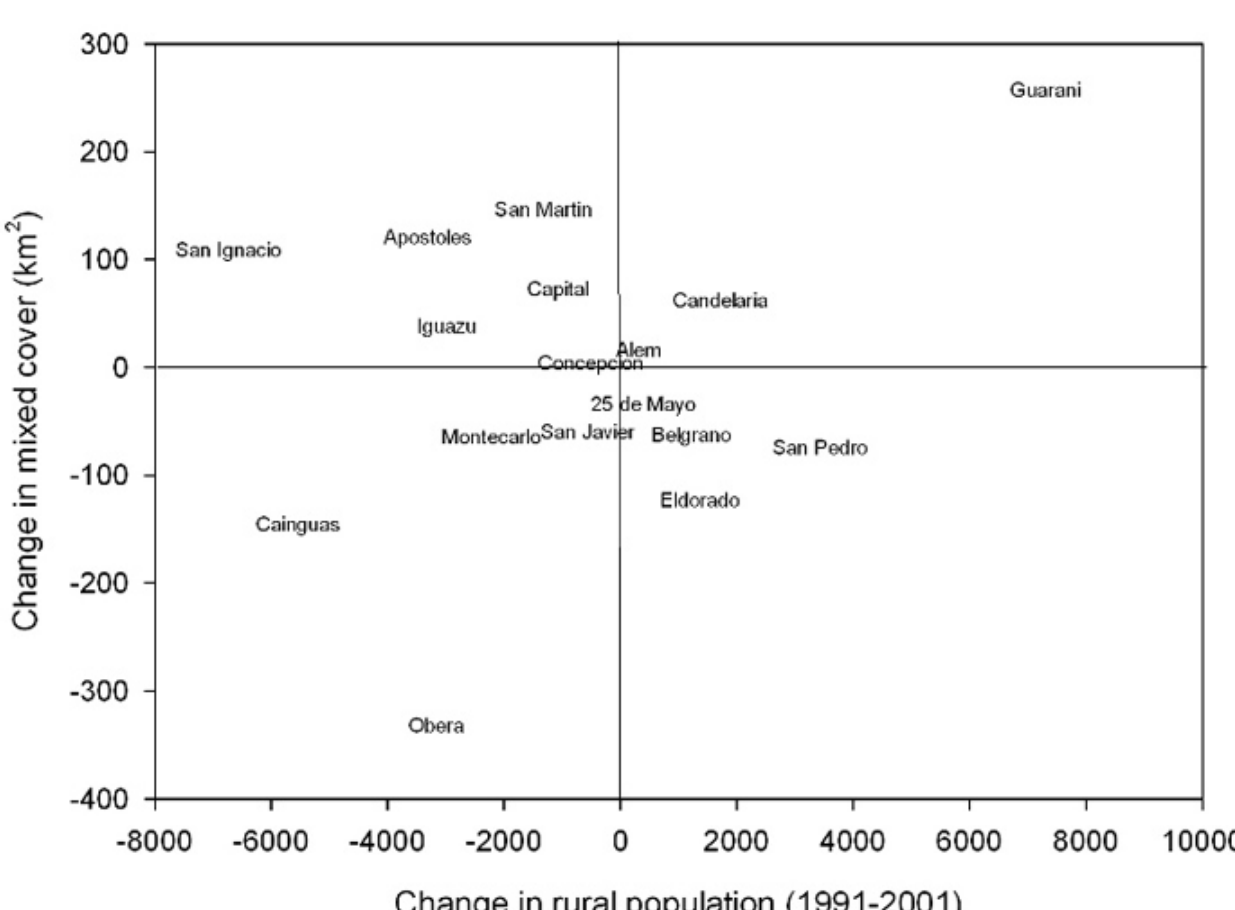
Fig. 5. Relationship between the change in mixed cover between 1989 and 2006 and the change in the rural population between 1991 and